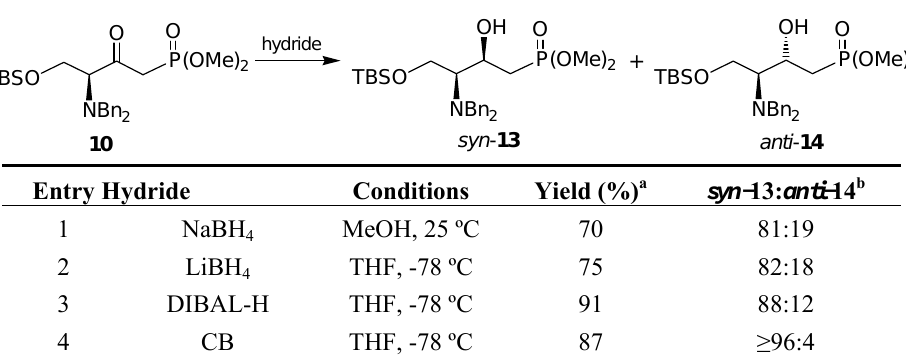
Table 2. Diastereoselective reduction of β -ketophosphonate 10